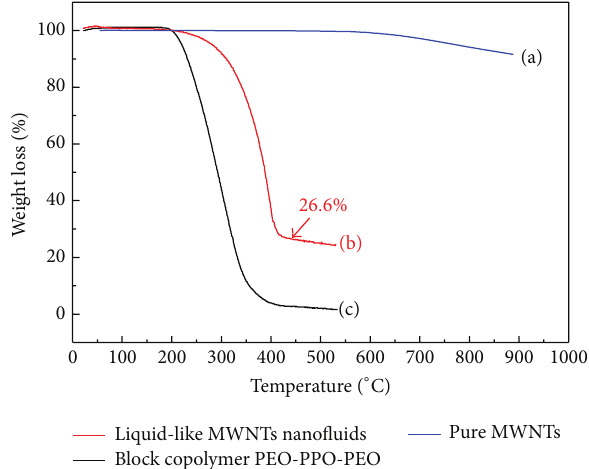
Figure 5: TGA curves of pure MWNTs, copolymer, and liquid-like